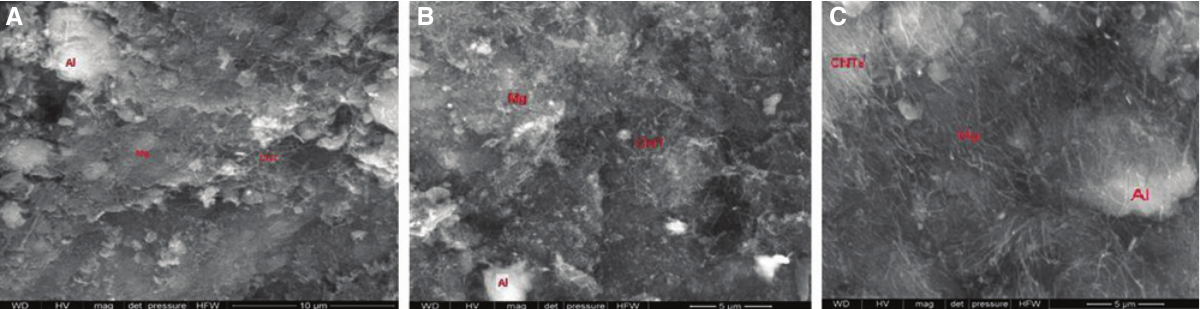
Figure 3 SEM images of AZ31-MWCNT composites: (A) 0.33 wt%, (B) 0.66 wt%, (C) 1.0 wt%.